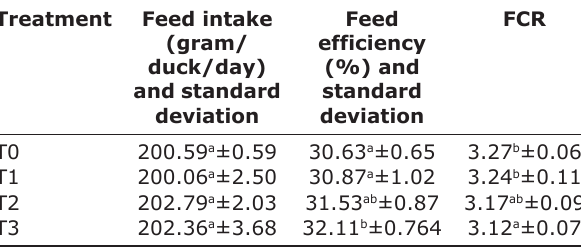
Table-2: Average of feed intake, feed efficiency, and feed conversion ratio.